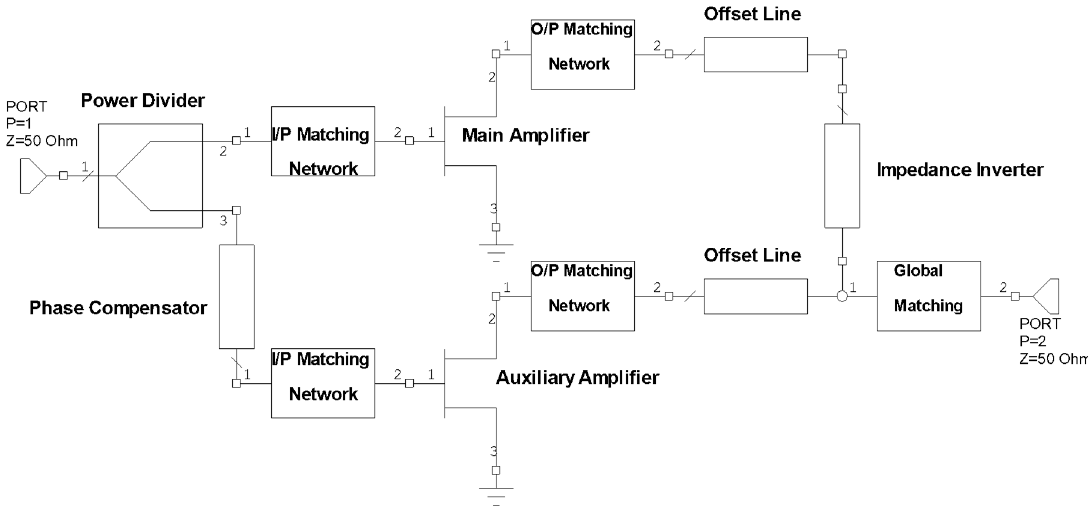
Figure 1. Structure of the Doherty power amplifier.